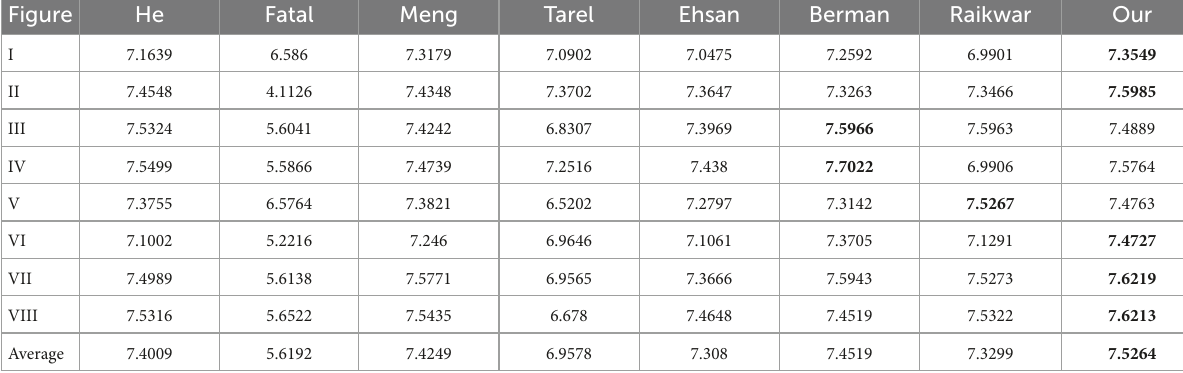
TABLE 3 Comparison of information entropy of the defogging images. Figure